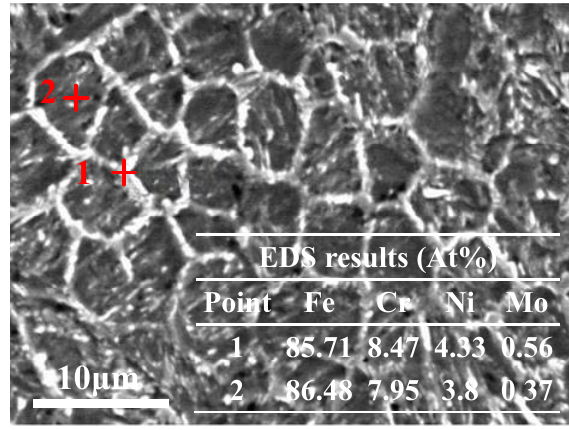
Figure 5. EDS analysis of structure of the cladding layer top.